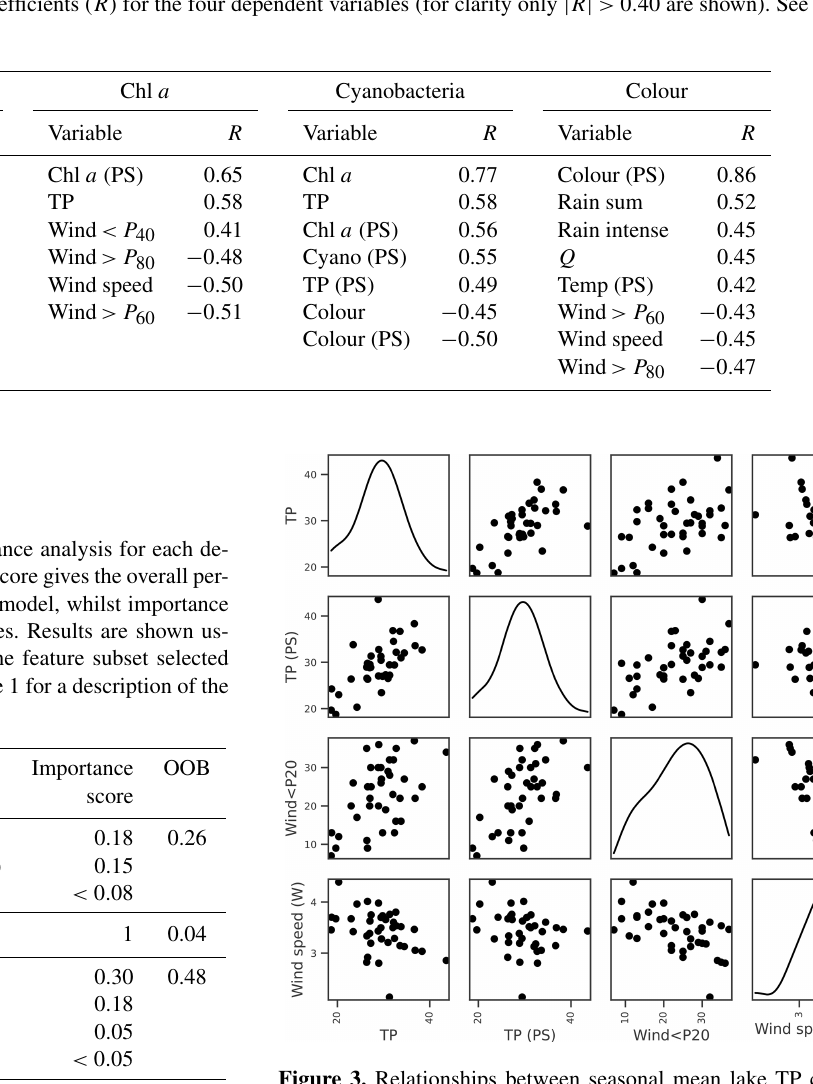
Figure 3. Relationships between seasonal mean lake TP concen- tration and potential explanatory variables of interest, including lake TP from the previous summer (PS), number of days when the daily mean wind speed < 20th percentile (wind <P 20 ), and mean winter (Nov–Apr) wind speed. Density plots estimated using kernel density estimation (kde) are shown along the